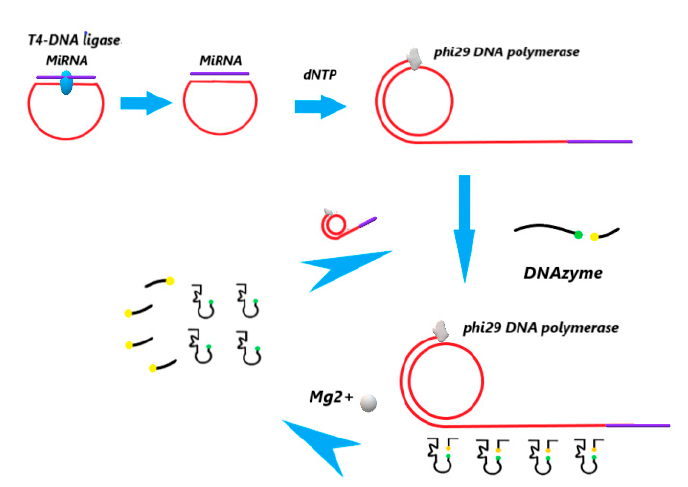
Figure 1. Schematic of microRNA detection based on rolling circle amplification (RCA) and